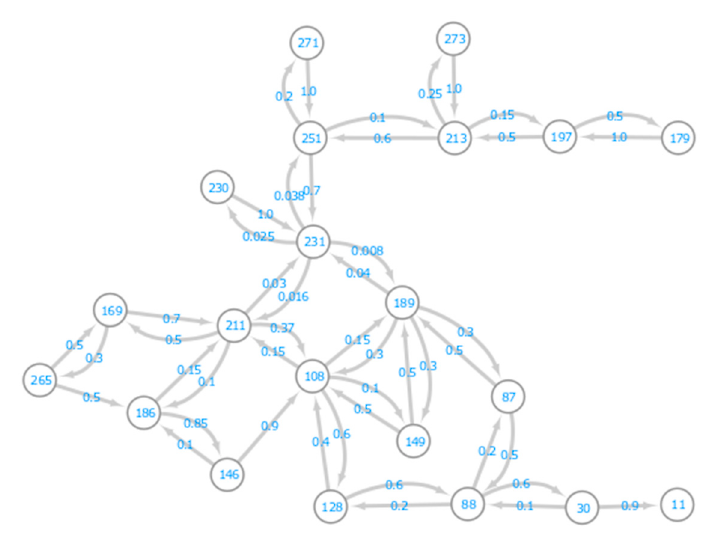
Figure 4. Graph with specific topology corresponding to the geographic map in the Hikone sightseeing area. Identical numbers in nodes correspond to those of meshes in Figure 2.